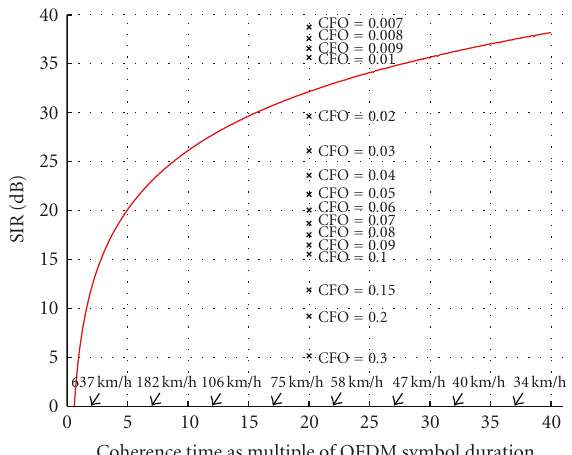
Figure 6: SIR as a function of carrier frequency o ff set (CFO). Obtained from (23) with static channel, SNR Γ = ∞ and system parameters are as in Figure 1.